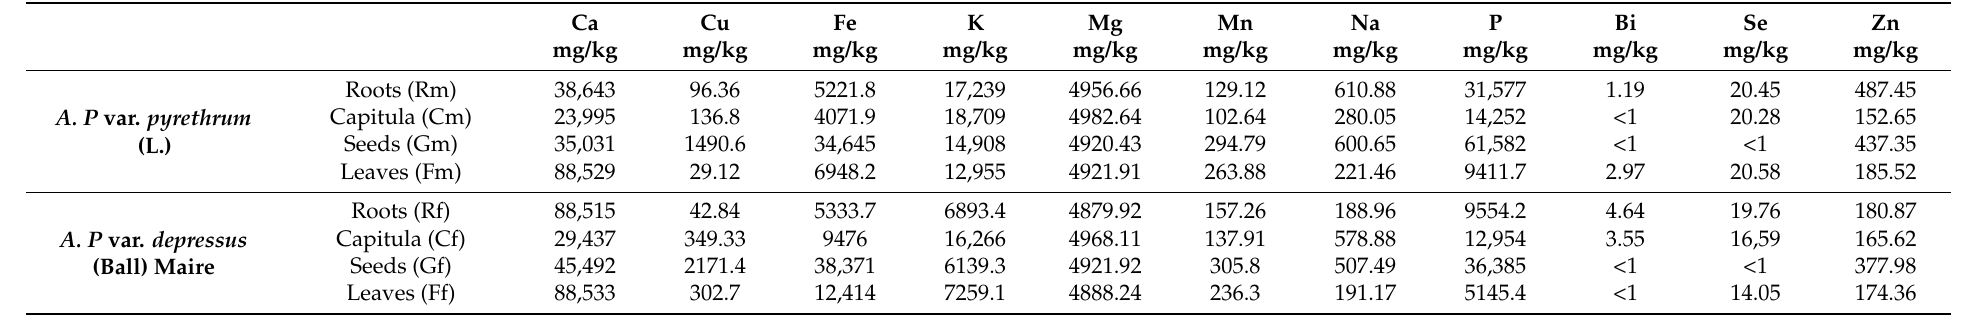
Table 3. Mineral content in different parts (leaves, capitula, roots, and seeds) of A. P var. pyrethrum (L.) and A. P var. depressus (Ball) Maire mg/Kg dry